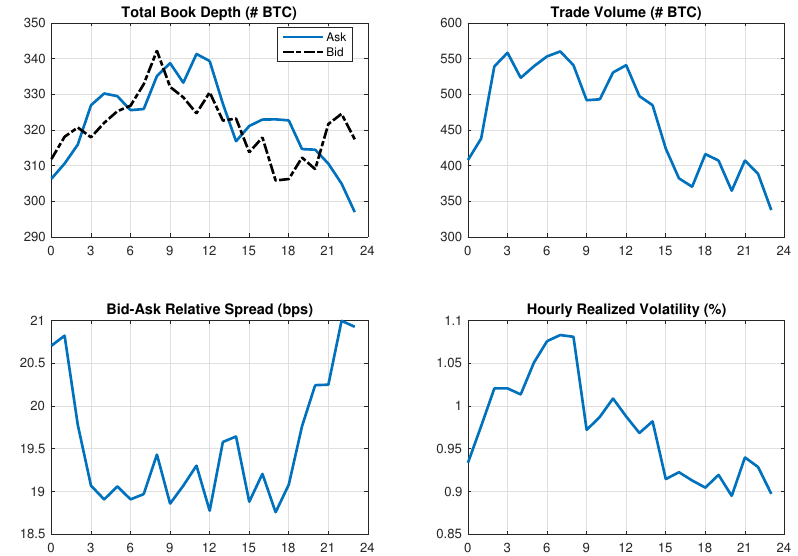
Figure 4. Depth, volume, spread, and volatility over 24-h trading day (Eastern